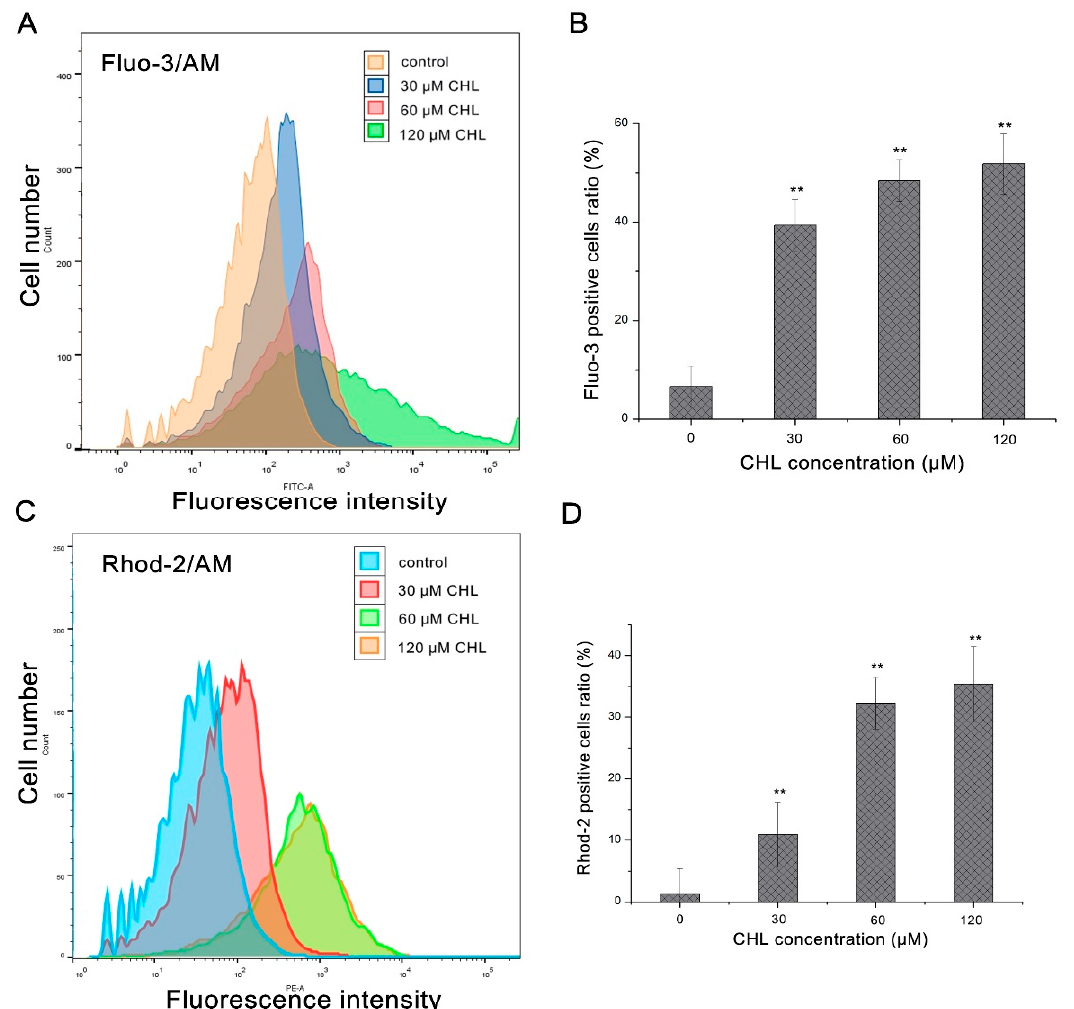
Figure 4. Analysis of cytosolic and mitochondrial Ca 2+ levels in HepG2 cells after treatment with CHL. ( A , C ): Analysis of Fluo ‐ 3 and Rhod ‐ 2 staining by flow cytometry. ( B ): Quantification levels of Fluo ‐ 3 fluorescence. ( D ): Quantification levels of Rhod ‐ 2 fluorescence. ** p ≤ 0.01 vs. the negative